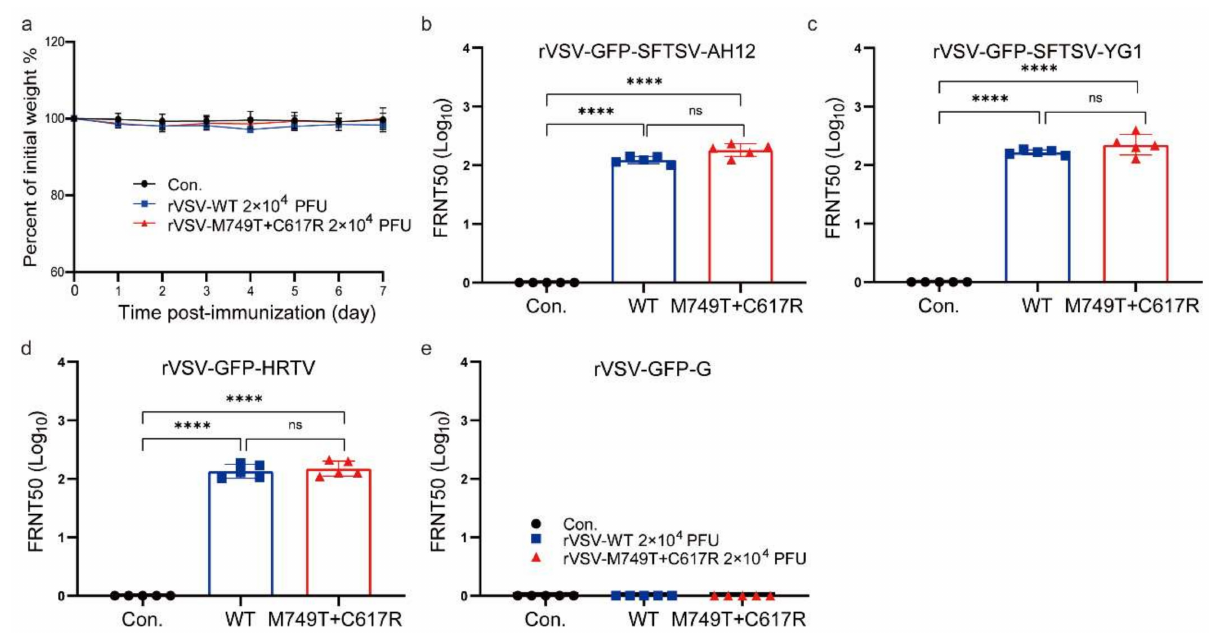
Figure 3. The humoral responses in mice elicited using rVSV-WT and rVSV-M749T + C617R. Three groups of C57/BL6 IFNAR − / − mice ( n = 5 per group) were i.p. immunized with rVSV-WT, rVSV- M749T + C617R, and DMEM (2 × 10 4 PFU). ( a ) Mouse body weight changes after